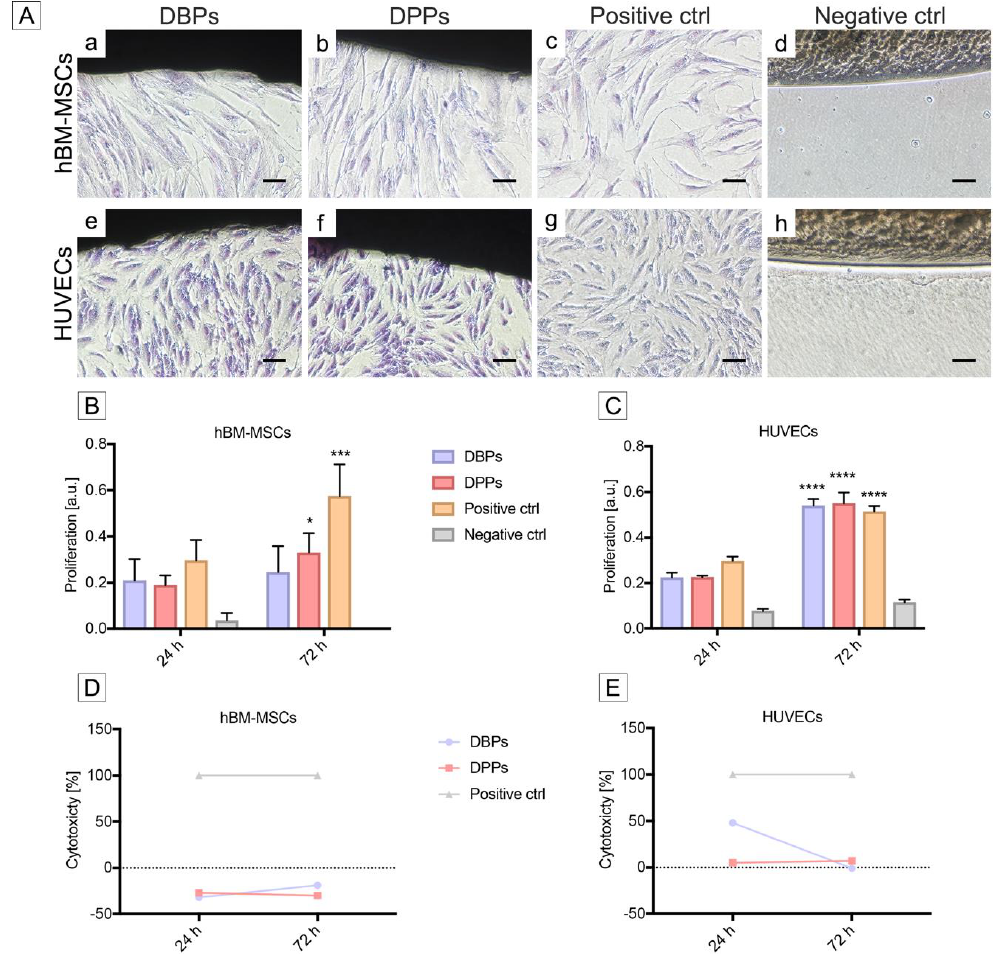
Figure 8. Bioactivity of bovine and porcine pericardia after TRICOL decellularization. ( A ) Contact assay with human bone marrow mesenchymal stem cells (hBM-MSCs) and umbilical vein endothelial cells (HUVECs). Both cell types displayed typical morphology, respectively spindle-shape and cobblestone-like, when cultured in contact with bovine and porcine decellularized scaffolds (a and b, as well as e and f), similarly to seeded alone (positive controls: c and g). In the cytotoxic glue environment (negative control), no cell growth was evident (d and h). Scale bar: 100 µm. ( B ) Proliferation assay for hBM-MSCs. When compared to positive controls (culture plastic support), no proliferation differences were observed at 24 hours, while increases were revealed in respect to both decellularized scaffolds and between porcine and bovine ones. The data are presented as mean ± standard deviation (SD). * p <0.5, *** p <0.001, **** p <0.0001. ( C ) Proliferation assay for HUVECs. Differences in proliferation were not evident at 24 hours, but at 72 hours among all groups considered. Data are presented as mean ± SD. Significance differences are shown inside the same group with respect to time. * p <0.5, *** p <0.001, **** p <0.0001. ( D ) Lactate dehydrogenase (LDH) cytotoxicity assay for hBM-MSCs. The direct contact with decellularized bovine and porcine pericardial scaffolds did not induce hBM-MSCs cytotoxicity either at 24 or 72 h. ( E ) LDH cytotoxicity assay for HUVECs. Cytotoxicity of HUVECs was observed high at 24 hours and decreased near 0 at 72 hours after seeding onto decellularized bovine and porcine pericardial scaffolds. Data are presented as mean ± SD. DBP= Decellularized Bovine Pericardium, DPP= Decellularized Porcine Pericardium, hBM-MSCs= human bone marrow-mesenchymal stem cells, and HUVECs= human umbilical vein endothelial cells.